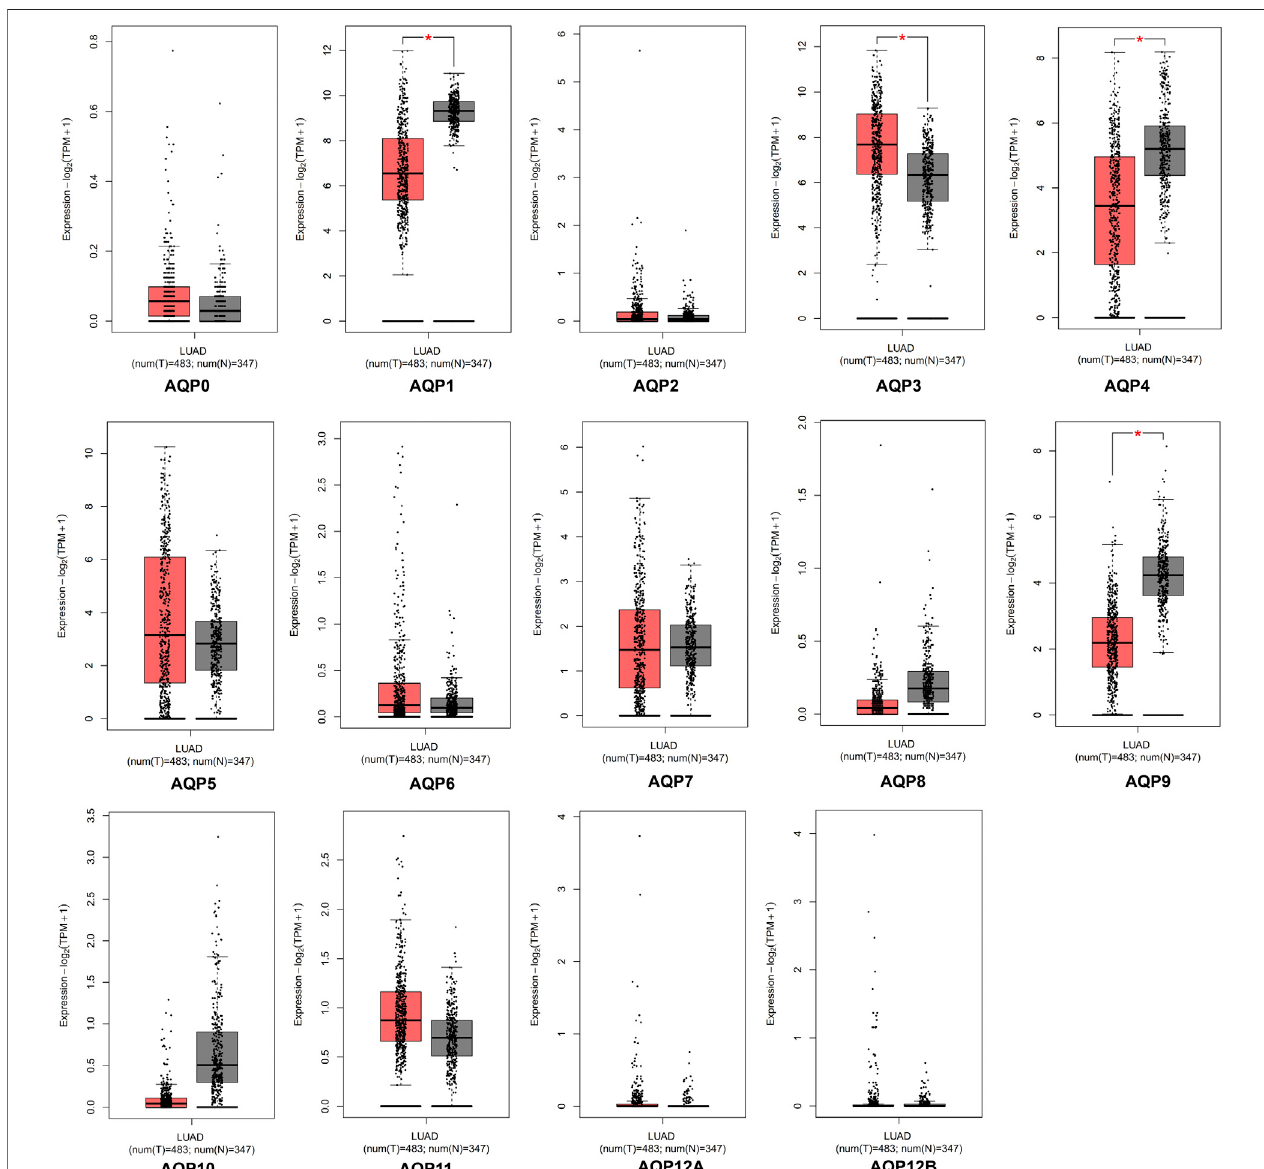
FIGURE 1 | mRNA expression of AQPs family members in LUAD via GEPIA database. Red box, tumor samples; gray box, normal samples; T, tumor; N, normal (* p < 0.05).